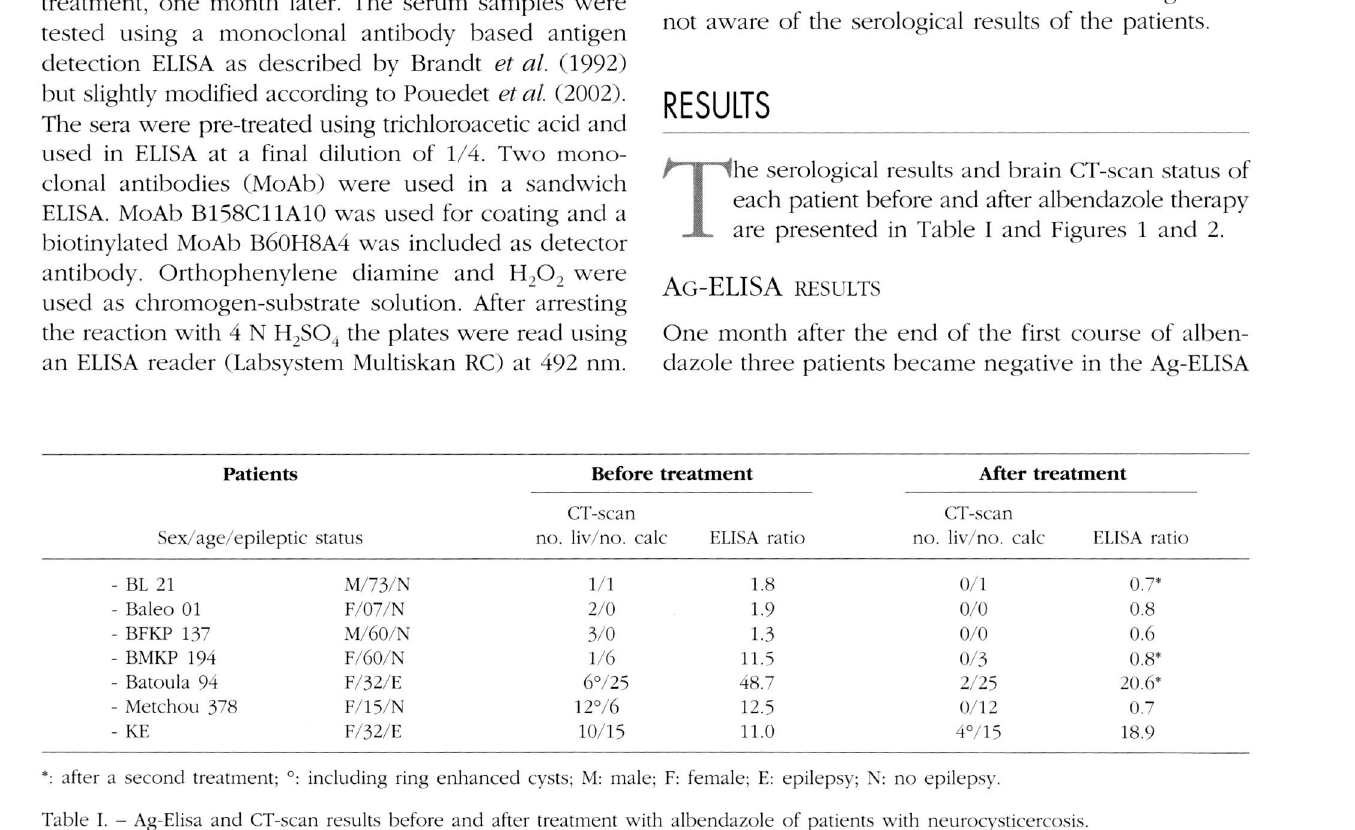
Table I. — Ag-Elisa and CT-scan results before and after treatment with albendazole of patients with neurocysticercosis.